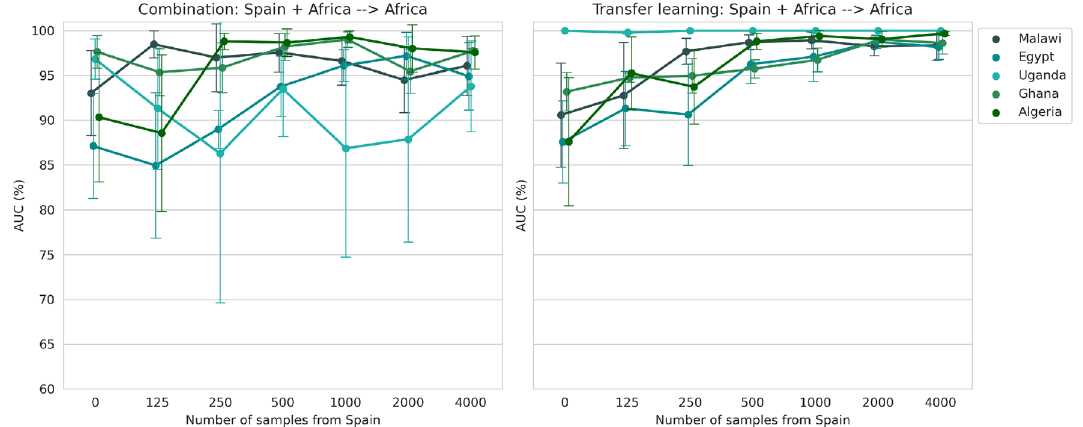
Figure 3. The AUC score as a result of combining the dataset acquired in Spain with the US samples acquired in each African centre independently or after fine-tuning the Spanish model, trained with varying sample size, with US images from each African centre independently.